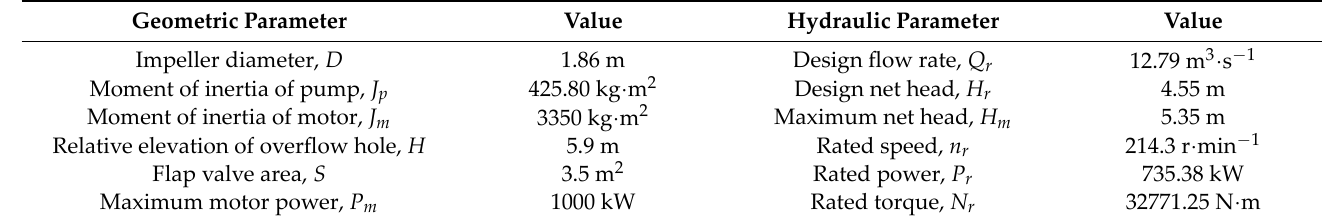
Figure 1. Diagram of a large axial flow pump station system. Table 1. Characteristic parameters of a large axial flow pump station